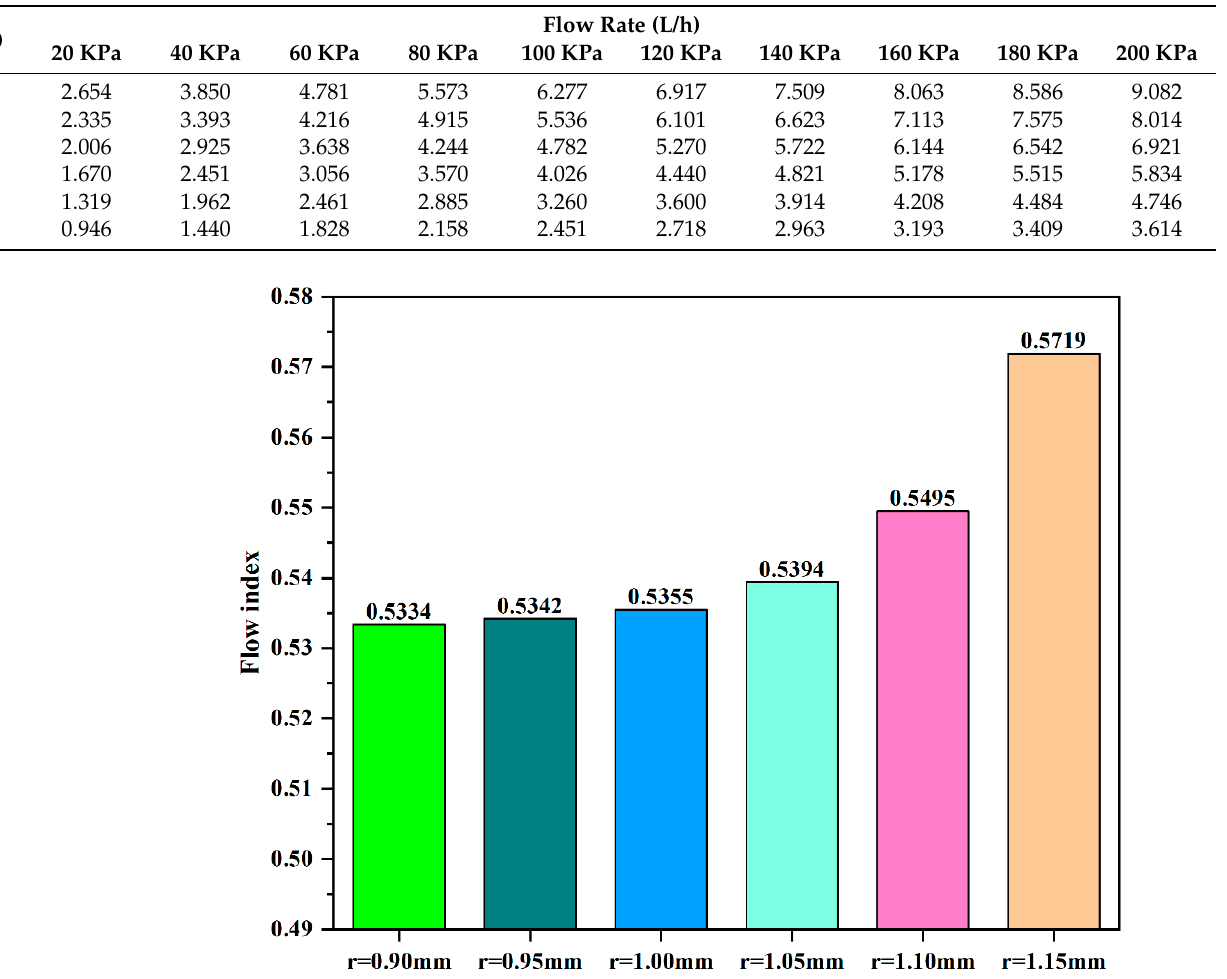
Figure 5. The flow indexes of the CWRLC emitter with different parameters r.